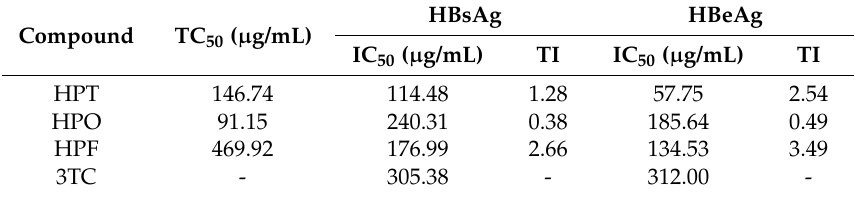
Table 1. TI values of three lignans and 3TC for HBsAg and HBeAg secretion from HepG2.2.15